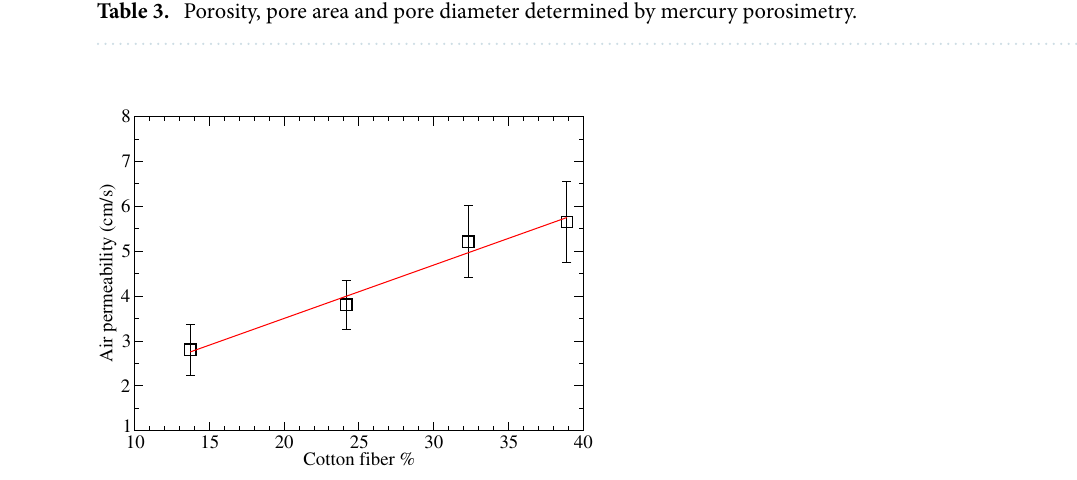
Table 3. Porosity, pore area and pore diameter determined by mercury porosimetry.